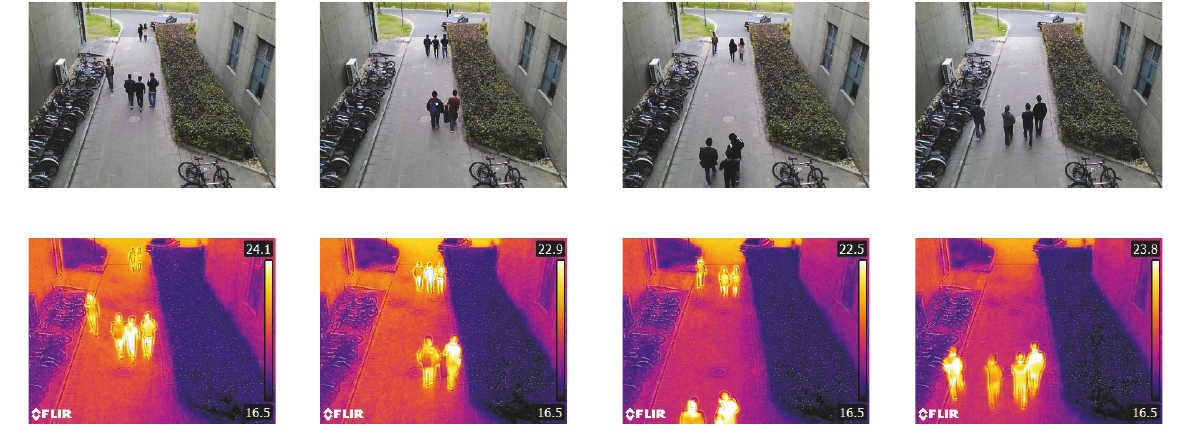
Figure 5: Examples of experimental